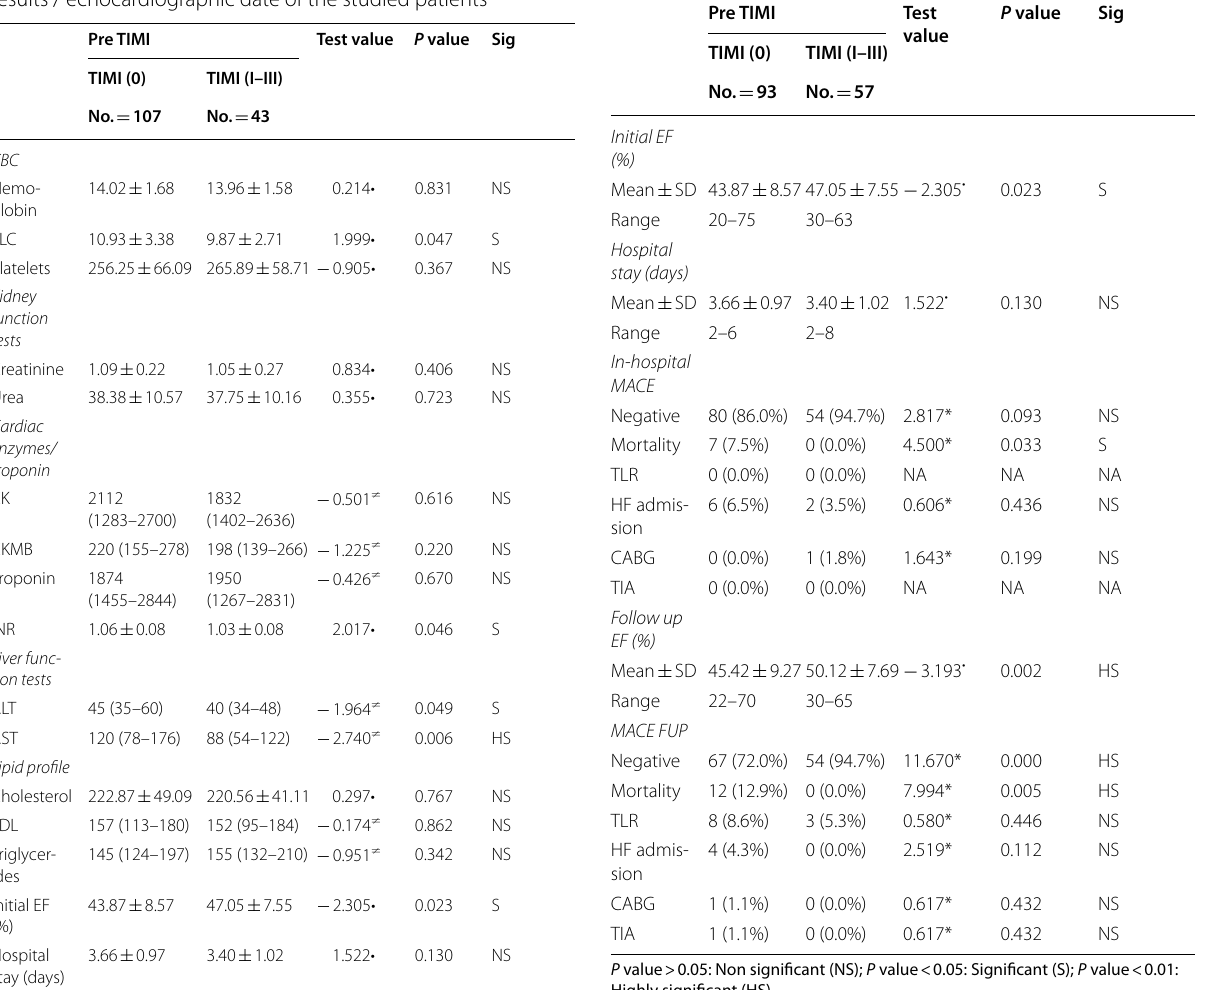
Table 5 Follow up results of the studied